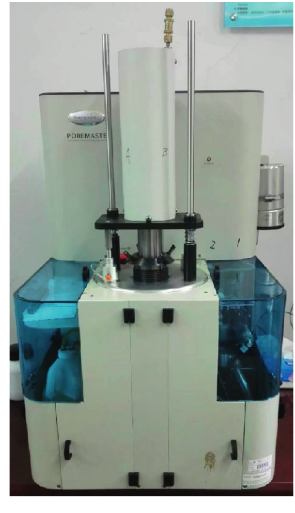
Figure 9: Mercury